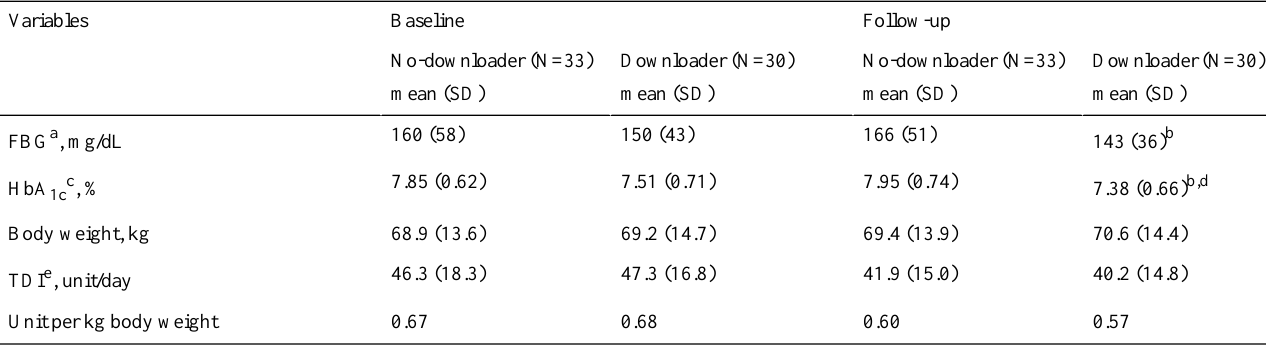
Table 2. Fasting blood glucose, glycated hemoglobin, body weight, and total daily insulin at baseline and follow-up visit in subjects enrolled in the study and divided as No-downloader and Downloader.